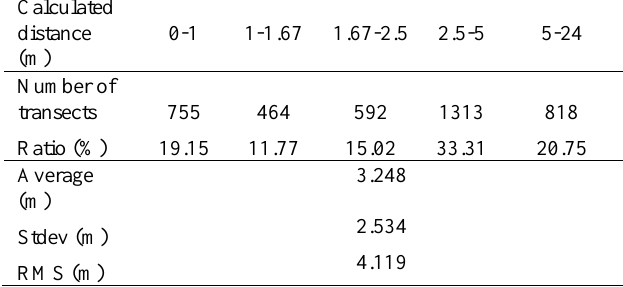
Table 4. Accuracy assessment results for GOKTURK-2.